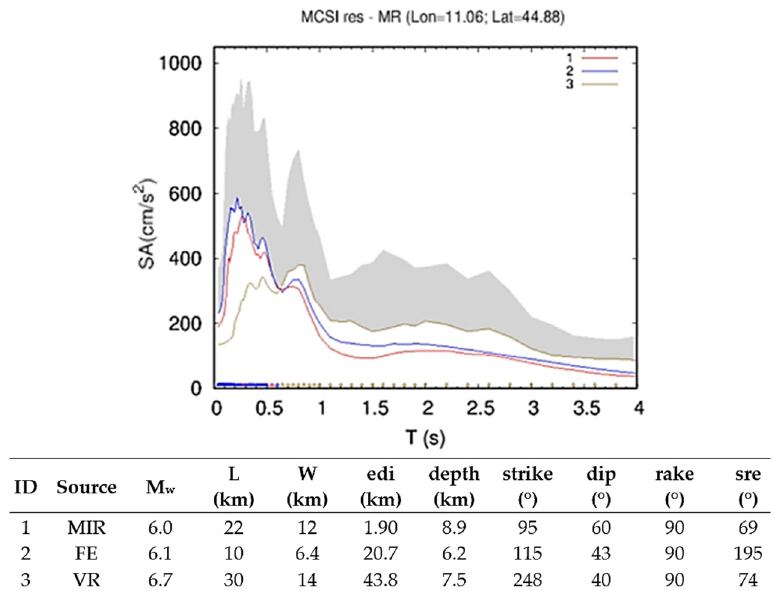
Figure 6. Simulated maximum credible seismic input (MCSI) for the selected sources. The grey band identifies the MCSI, as defined in [43], which is controlled by three sources: curves 1, 2 and 3 are the median spectra obtained from one hundred realizations of the rupture process for the sources MIR, FE and VR, respectively.